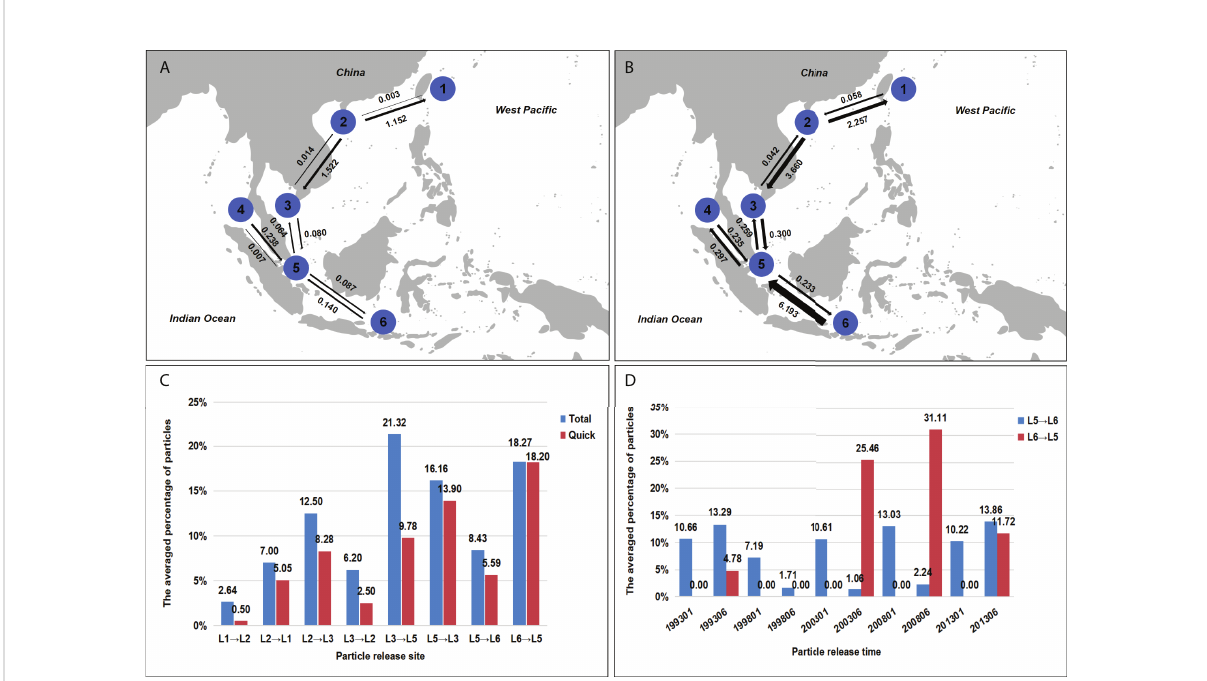
FIGURE 5 Gene fl ow ( Nm ) and Lagrangian particles transport simulations. (A) Gene fl ow by MIGRATE-n between adjacent S. polycystum populations in the Indo-Paci fi c convergence region based on mitochondrial cox 1+ cox 3, and (B) was based on nuclear ITS2. Numbers above/below the arrows represent migration rates in the direction of the arrow. Arrow thickness is scaled according to the value. (C) The averaged percentage of particles traveling in total released particles over all release experiments and the averaged percentage of particles traveling in a direct path. The arrow indicates the direction of particle transportation. In the legend, red corresponds to the direct path, and blue corresponds to all paths. (D) The percentage of particles traveling from one location to another in total released particles at different released times. Red: from L6 to L5, blue: from L5 to